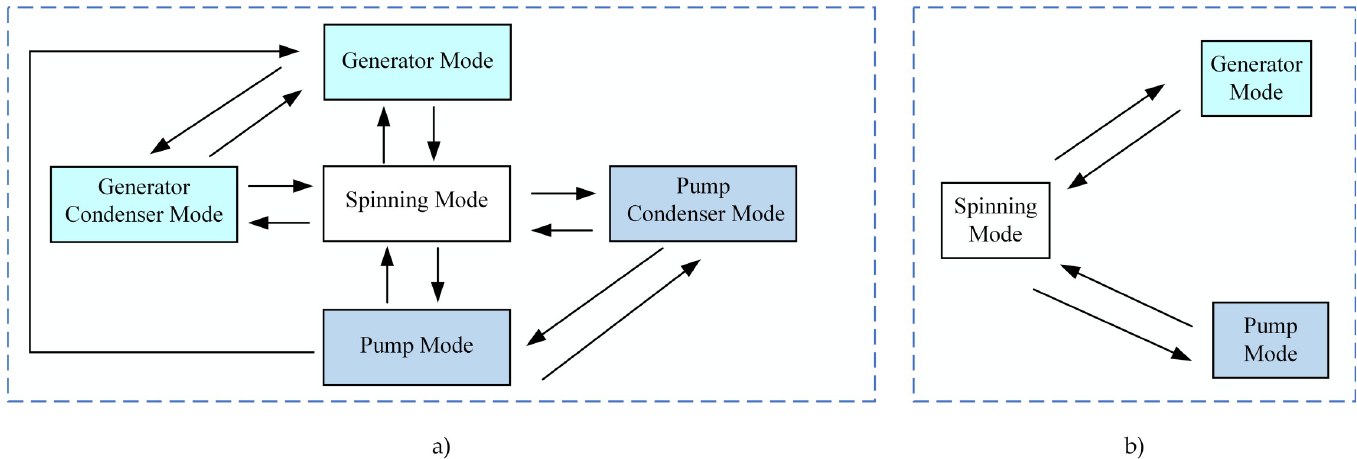
Fig 2. Operation mode transition diagrams of pumped storage units. (a) A typical mode transition diagram. (b) The mode transition diagram for frequency control.